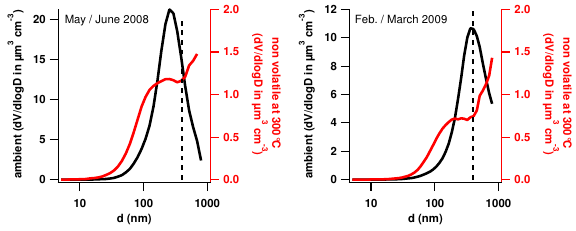
Figure 7. Average particle volume–size distribution measured at ambient temperature (black) and after crossing the TD (red) for the 2 campaigns. The dotted lines mark the mean cut-off diameter of d max